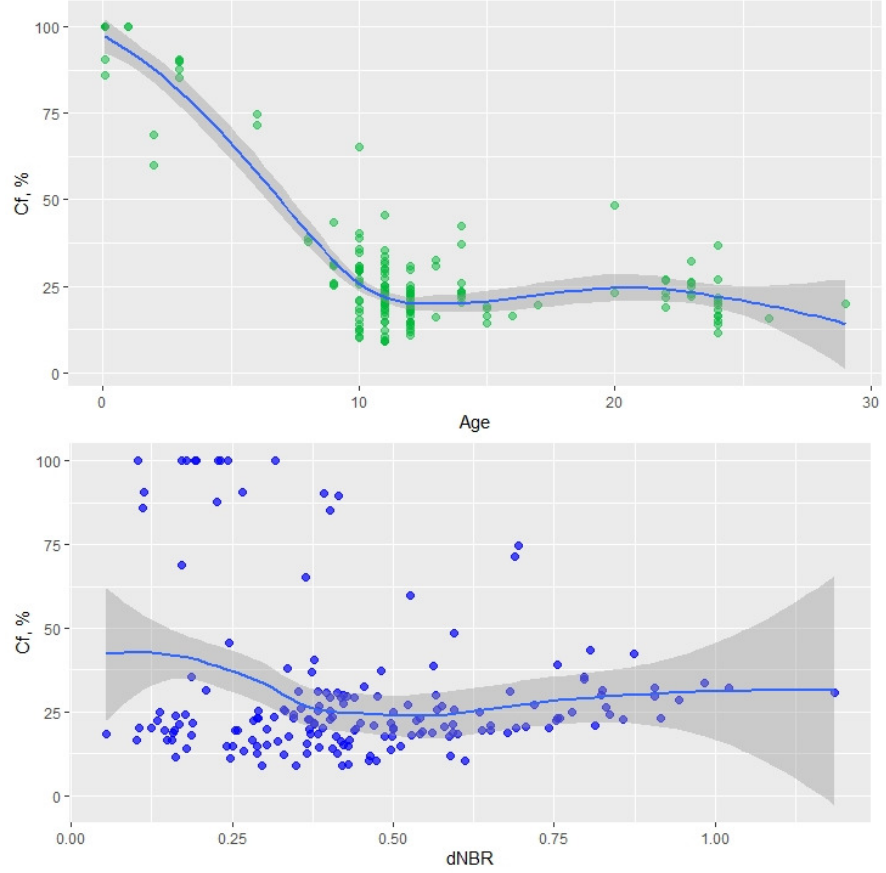
Figure 2. Relationship between the amount of biomass that is actually combusted during a wildfire ( C f ) and Age ( top ) and between C f and fire severity measured with remote sensing (dNBR) ( bottom ).